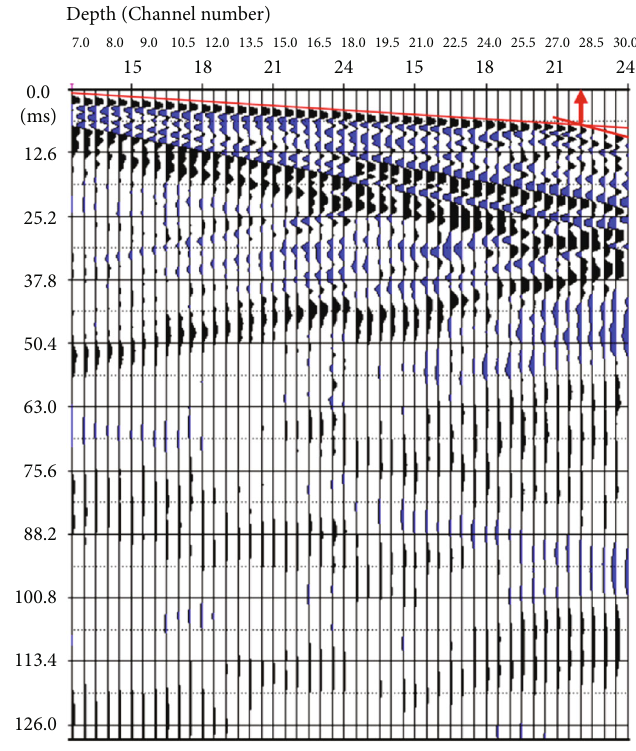
Figure 13: Waveform